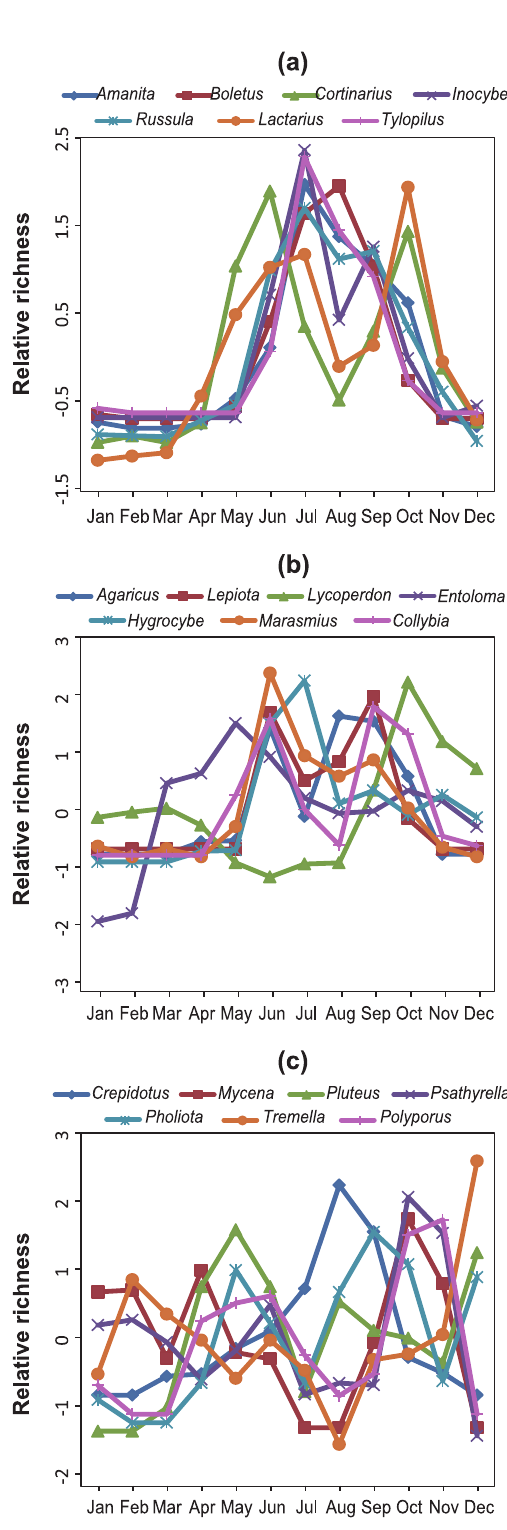
Figure 3. Intergeneric pattern of monthly change in number of fruiting species for ectomycorrhizal fungi (a), litter-decompos- ing fungi (b), and wood-decomposing fungi (c). Relative richness represents the standardized monthly mean number of fruiting species in each fungal genus.